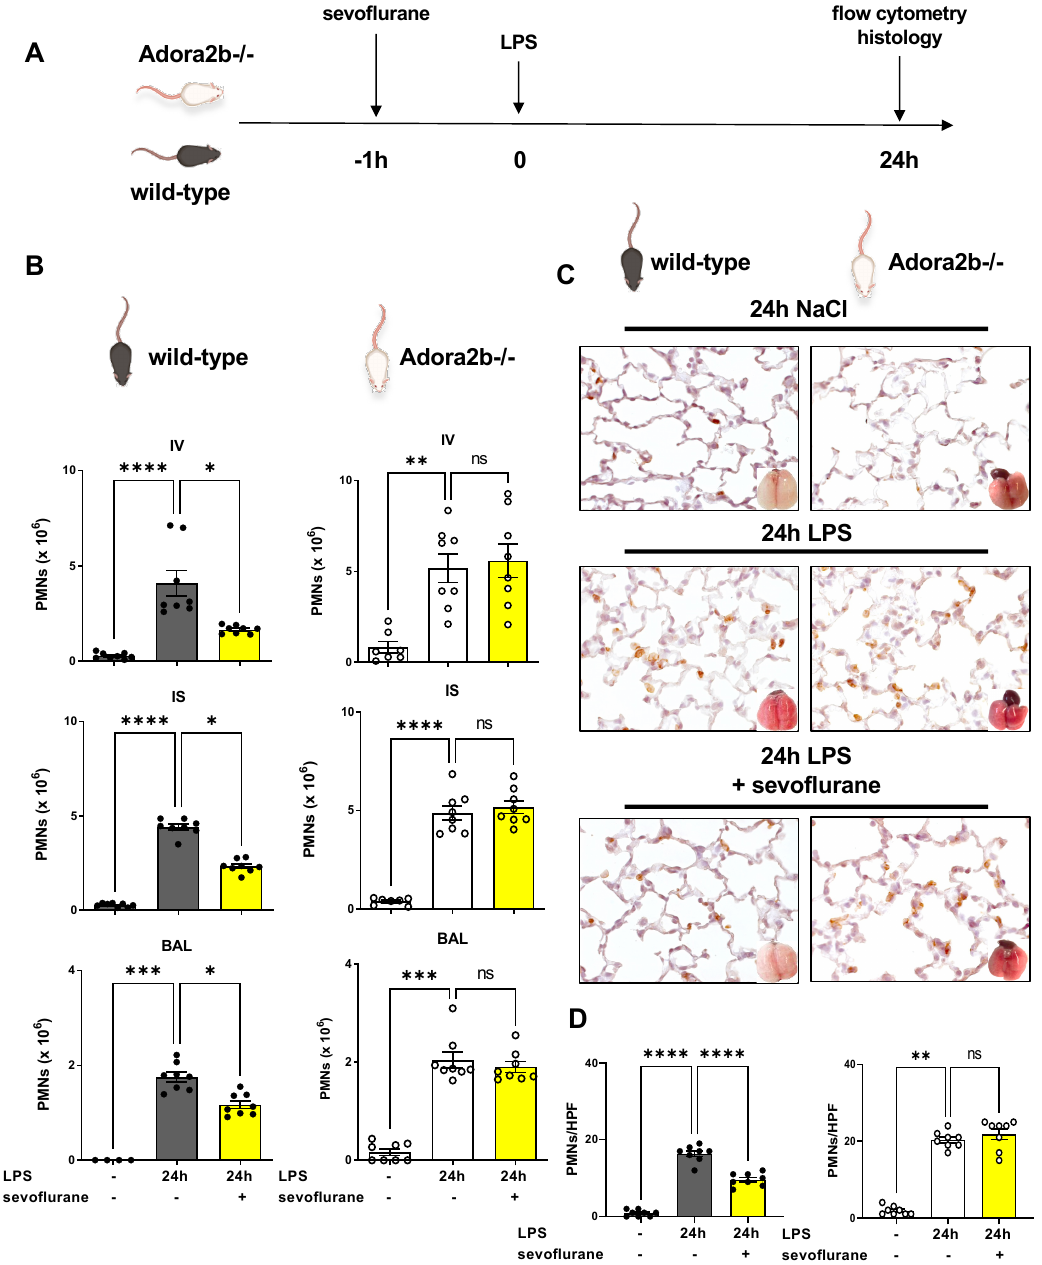
Figure 2. Effects of sevoflurane treatment on lipopolysaccharide (LPS)-induced migration of poly- morphonuclear neutrophils (PMNs) in wild-type and Adora2b − / − animals. ( A ) Wild-type and adenosine A2B receptor − / − (Adora2b − / − ) mice were treated with sevoflurane. 24 h after LPS ex- posure, PMNs counts were determined by flow cytometry, and immunochemistry experiments with the pulmonary tissue were performed. ( B ) PMN migration was determined in the intravascular space (IV), interstitial tissue (IS), and the bronchoalveolar lavage (BAL) in wild type and Adora2b − / − mice ( n = 6–8). ( C ) PMN sequestration into the pulmonary tissue was detected by an immunohisto- chemical method. PMNs were tackled with specific antibodies so that PMNs appear brown (images are presentative slides of n = 3 slides from each animal; n = 4 mice per group; 63 × magnification). ( D ) PMN counts were enumerated by light microscopy. PMNs from four representative high-power fields (HPF) were counted from three different slides ( n = 4 mice per group). Multiple group compari- son was analyzed by one-way ANOVA and Bonferroni correction or Kruskal-Wallis test. Data are presented as mean ± SEM; ns = not significant; * p < 0.05; ** p < 0.01; *** p < 0.001; **** p <